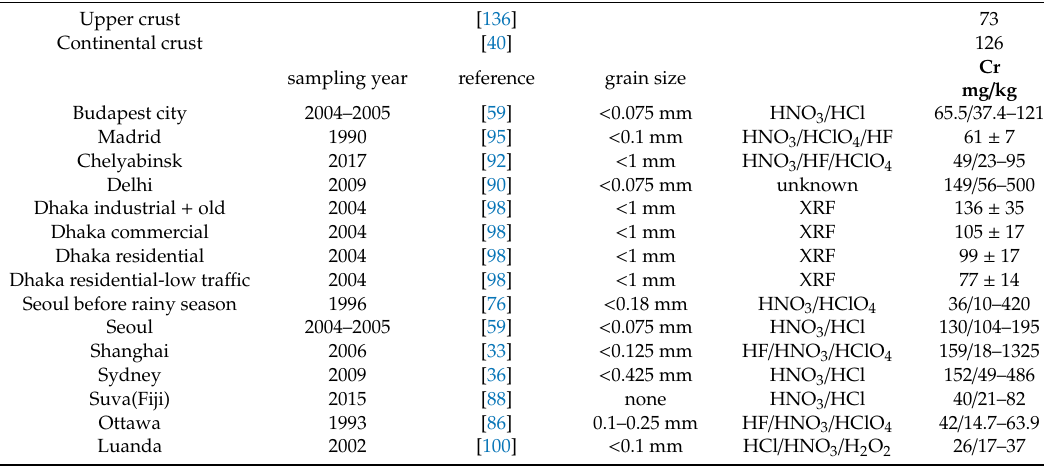
Table A28. Chromium in road